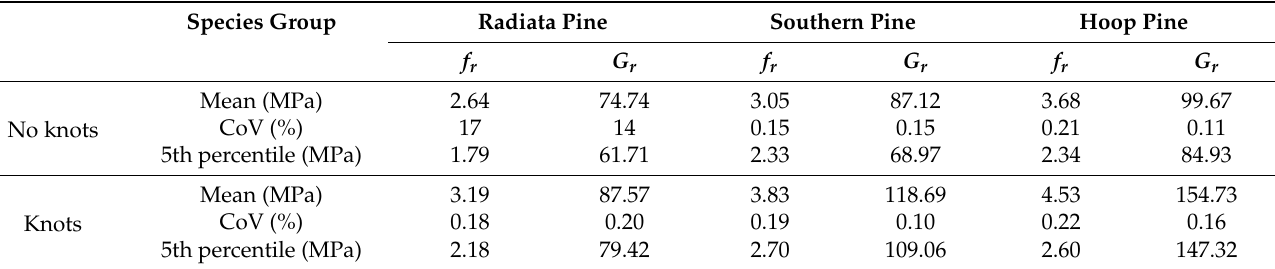
Table 8. Rolling shear properties with varying